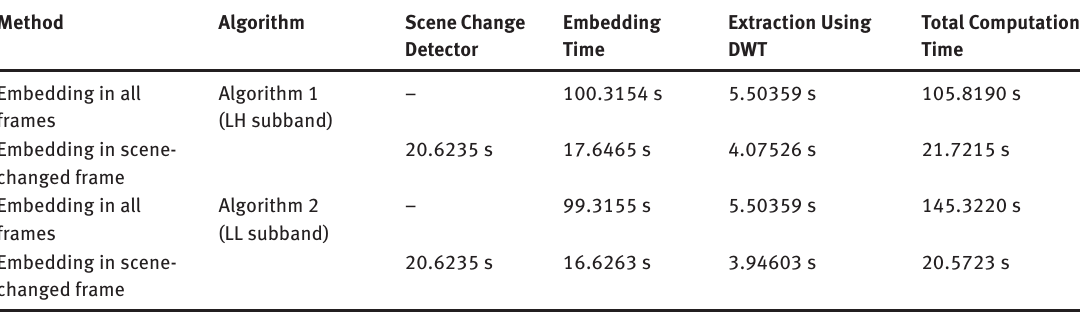
Table 10: Performance Measurements in Terms of Computational